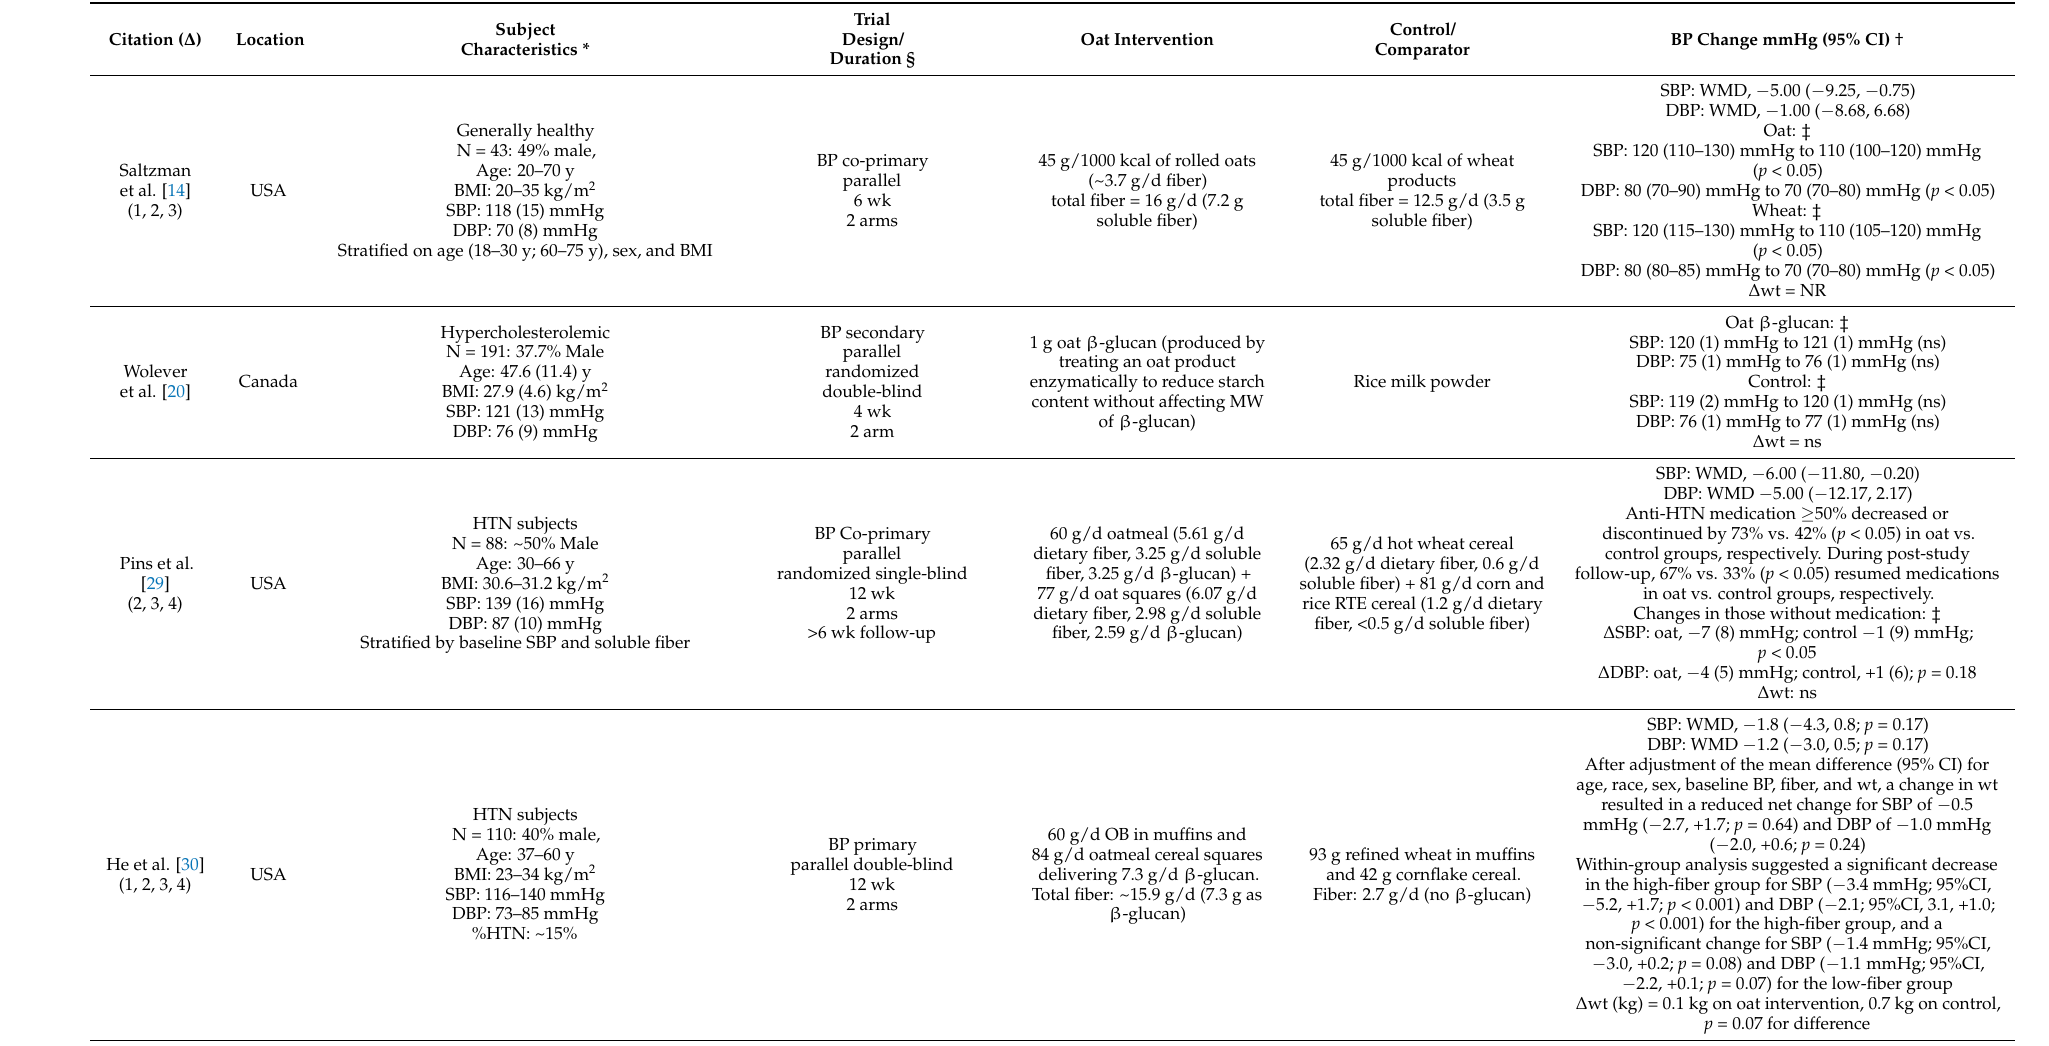
Table 2. Clinical studies published on oats with blood pressure